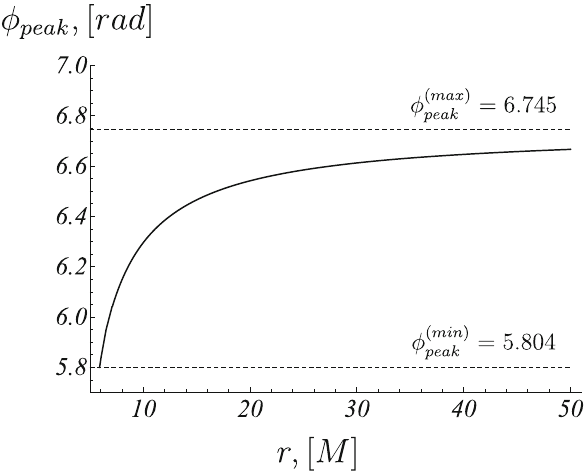
Fig. 11 Dependence of the maximum value of the azimuthal angle φ peak on the radial position of the emitting circular orbit r source for the outer accretion disk. We observe a monotonically increasing func- tion starting at the outer marginally stable orbit r + = 5 . 896 with ( r + ) = φ ( min ) = 5 . 804 and approaching asymptotically the value φ peak peak φ ( max ) = 6 . peak